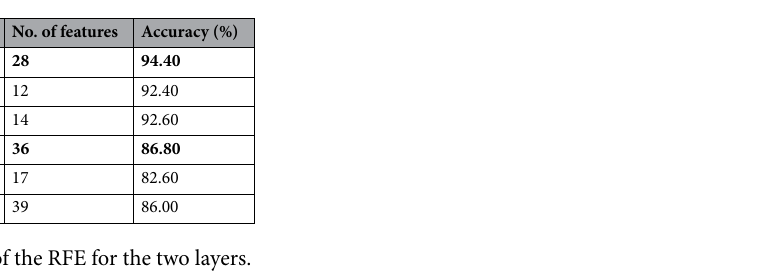
Figure 1. Selected features for both layers based on three different techniques of SVM, RF, and GB. The first row is for the first layer, and the second row is for the second layer.